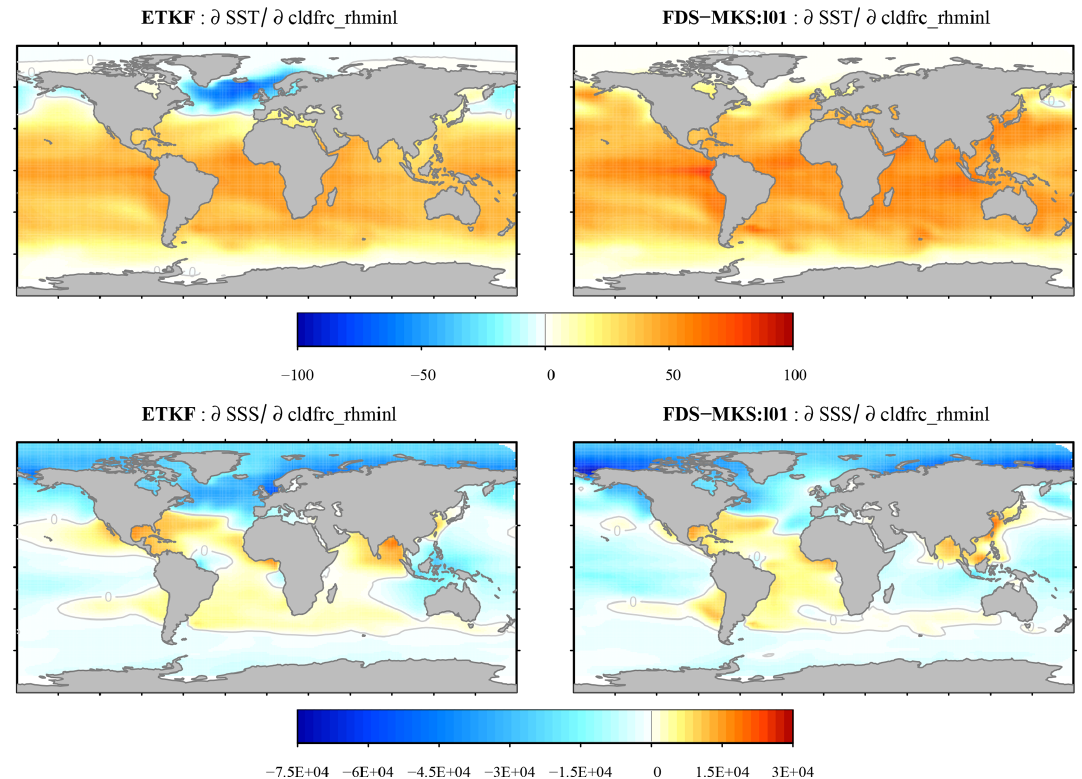
Figure 6. CESM experiment. Sensitivity of SST ( ◦ C) and SSS (PSU) to the minimum relative humidity for low stable cloud formation (CAM.clrfrc_rhmin) estimated from the ETKF background ensemble and the first iteration of the FDS-MKS. Isolines at value 0 shown in